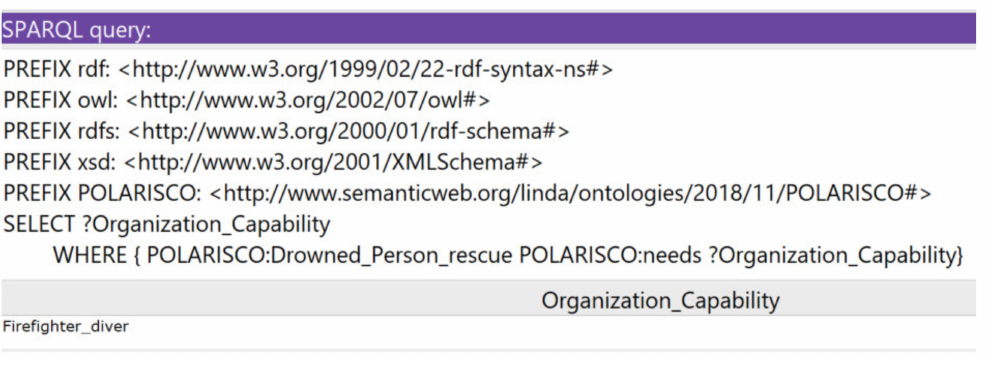
Figure 17. SPARQL query and result of the